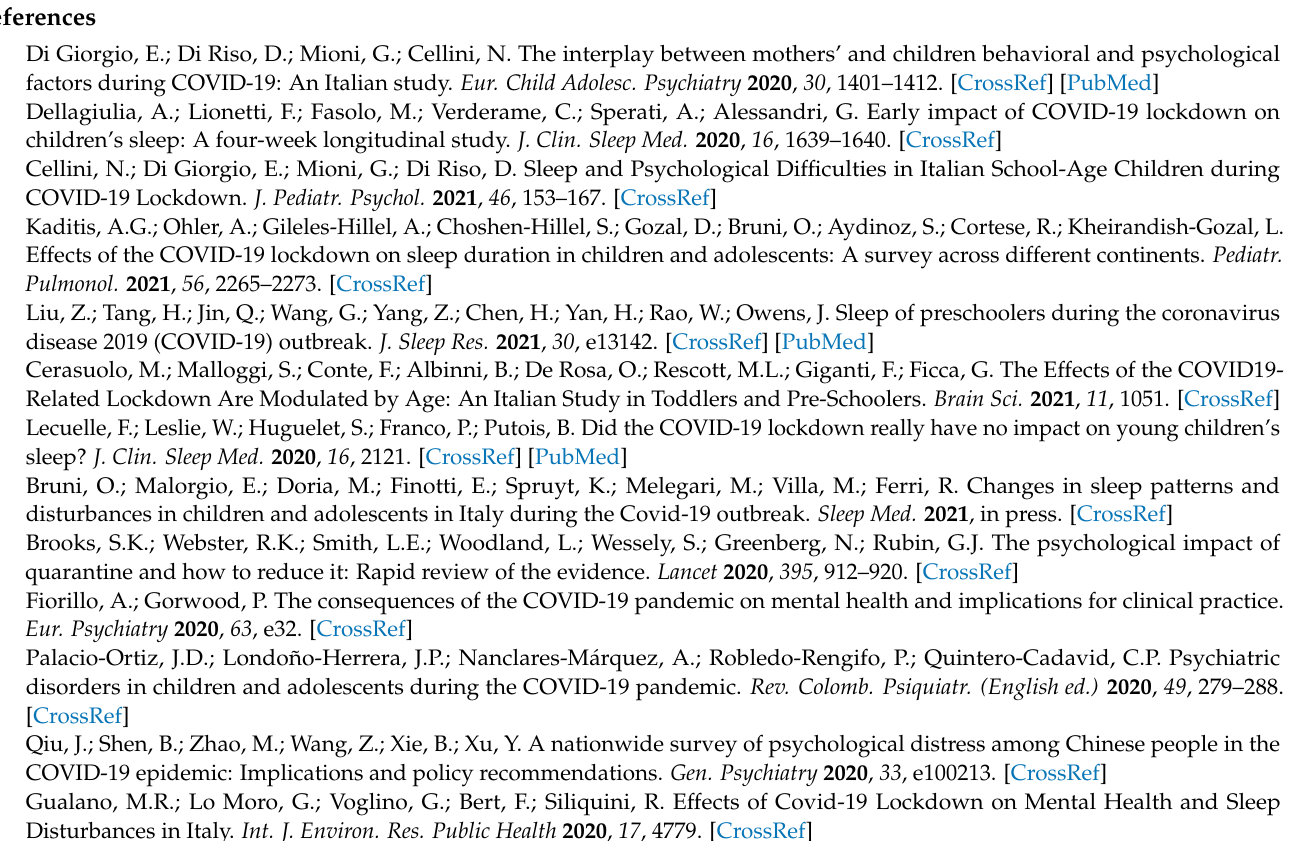
SEM Fit Indices, Table S3: Descriptive Statistics for All Participants, French, and Swiss, Table S4: Descriptive Statistics for the French Clusters, Table S5: Descriptive Statistics for the Swiss